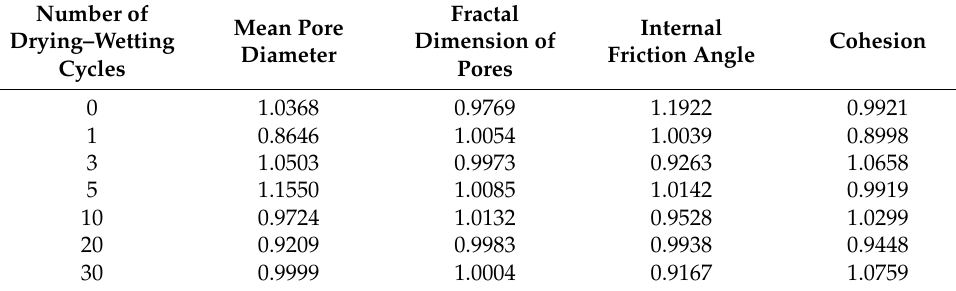
Table 10. Dimensionless processing